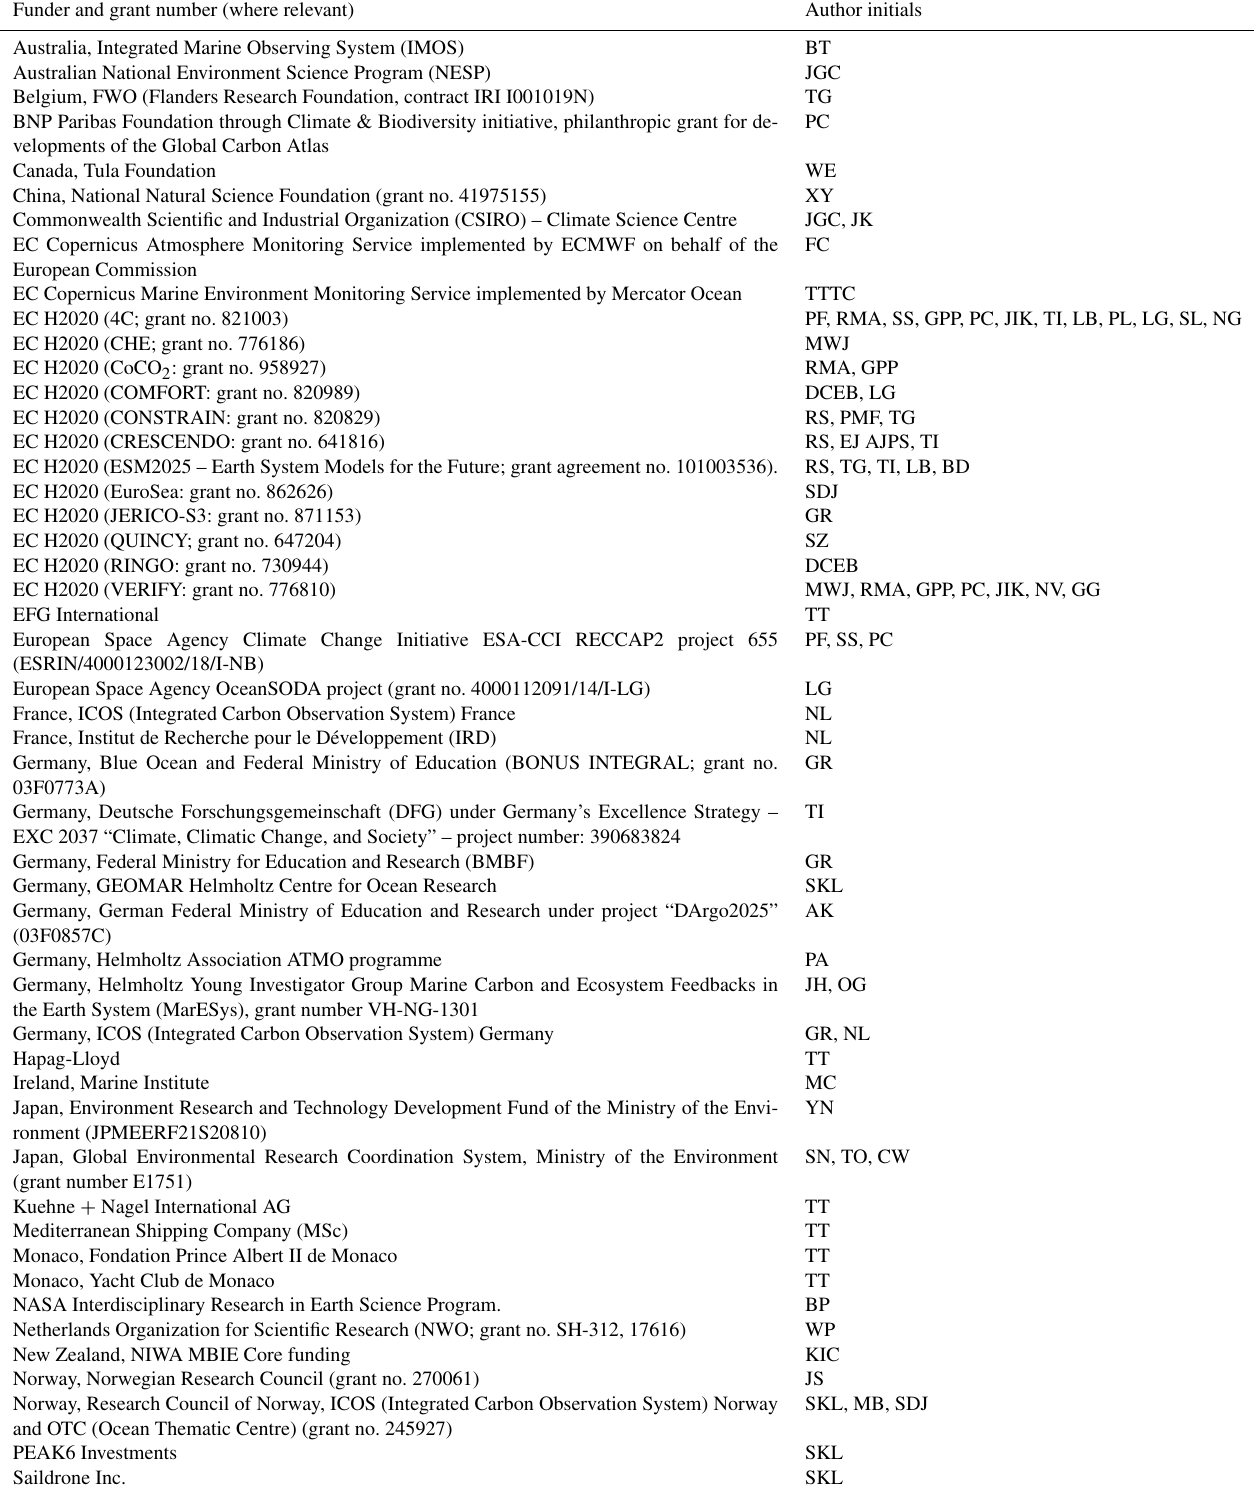
Table A9. Funding supporting the production of the various components of the global carbon budget in addition to the authors’ supporting institutions (see also the